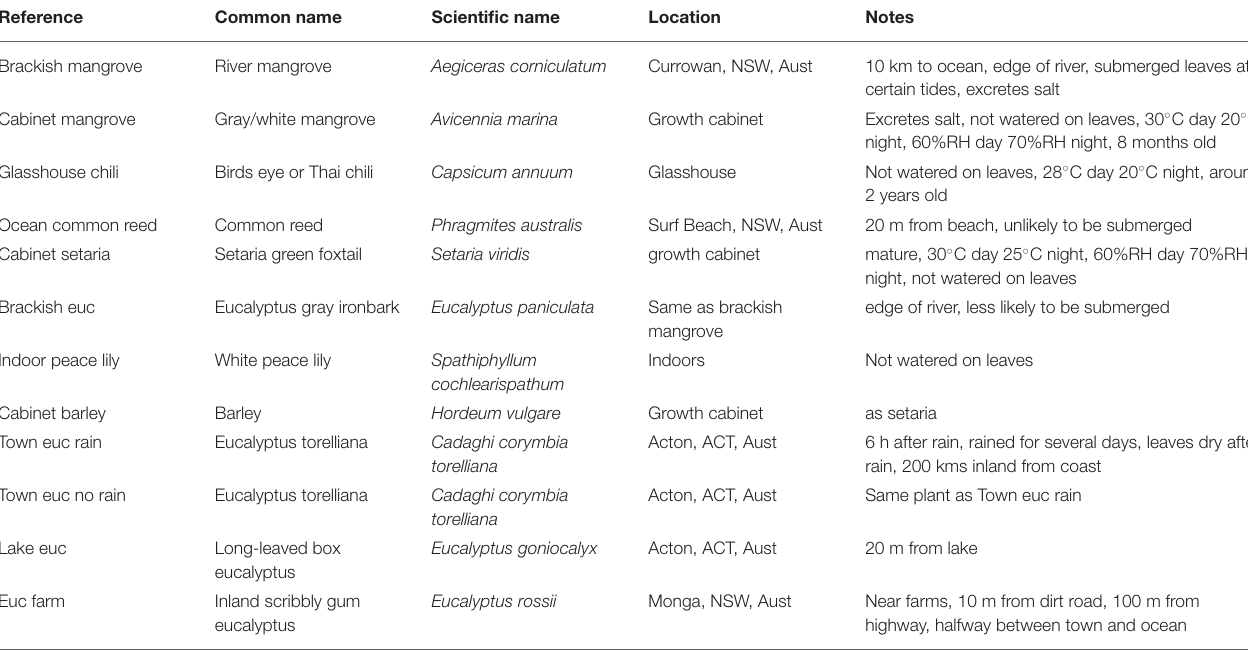
TABLE 1 | Sample reference, plant species and location of leaf wash